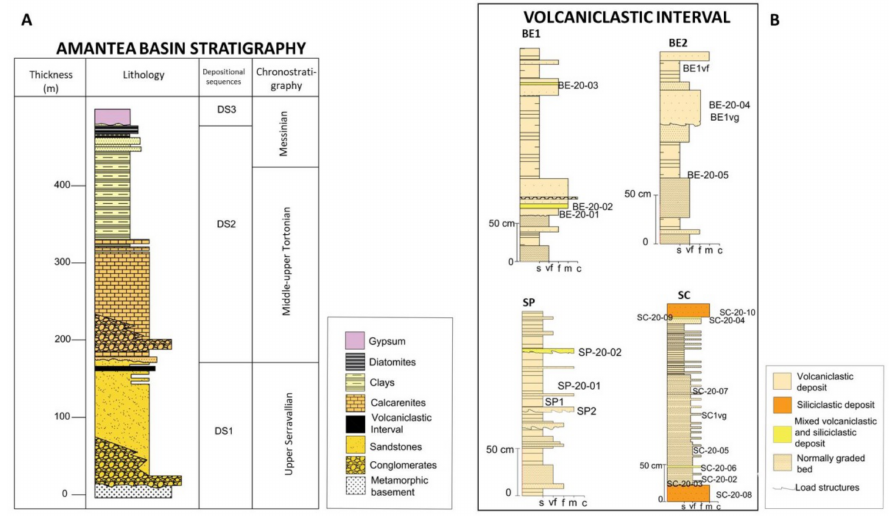
Figure 2. ( A ) Stratigraphic columns of the Amantea Basin, modified after [18] and ( B ) stratigraphic columns of the volcaniclastic